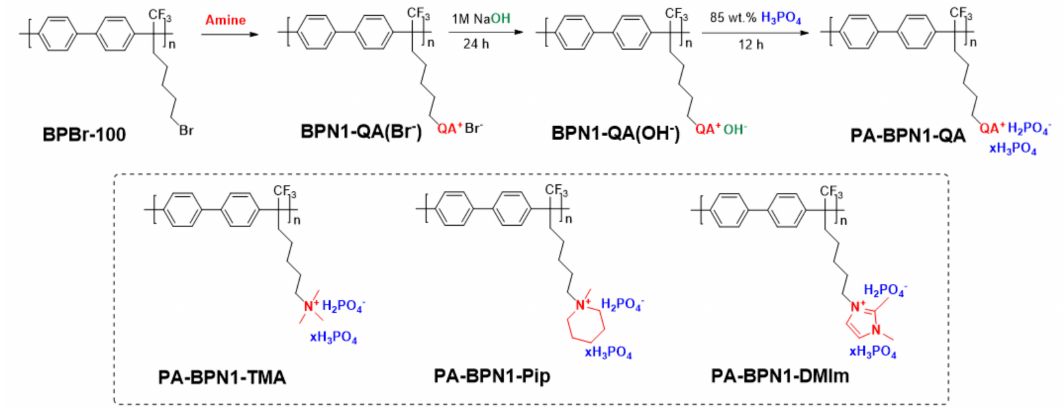
Figure 1. Synthetic scheme of PA-doped QA-phosphate ion-pair polymers (PA-BPN1-QA): PA-BPN1- TMA, PA-BPN1-Pip, and